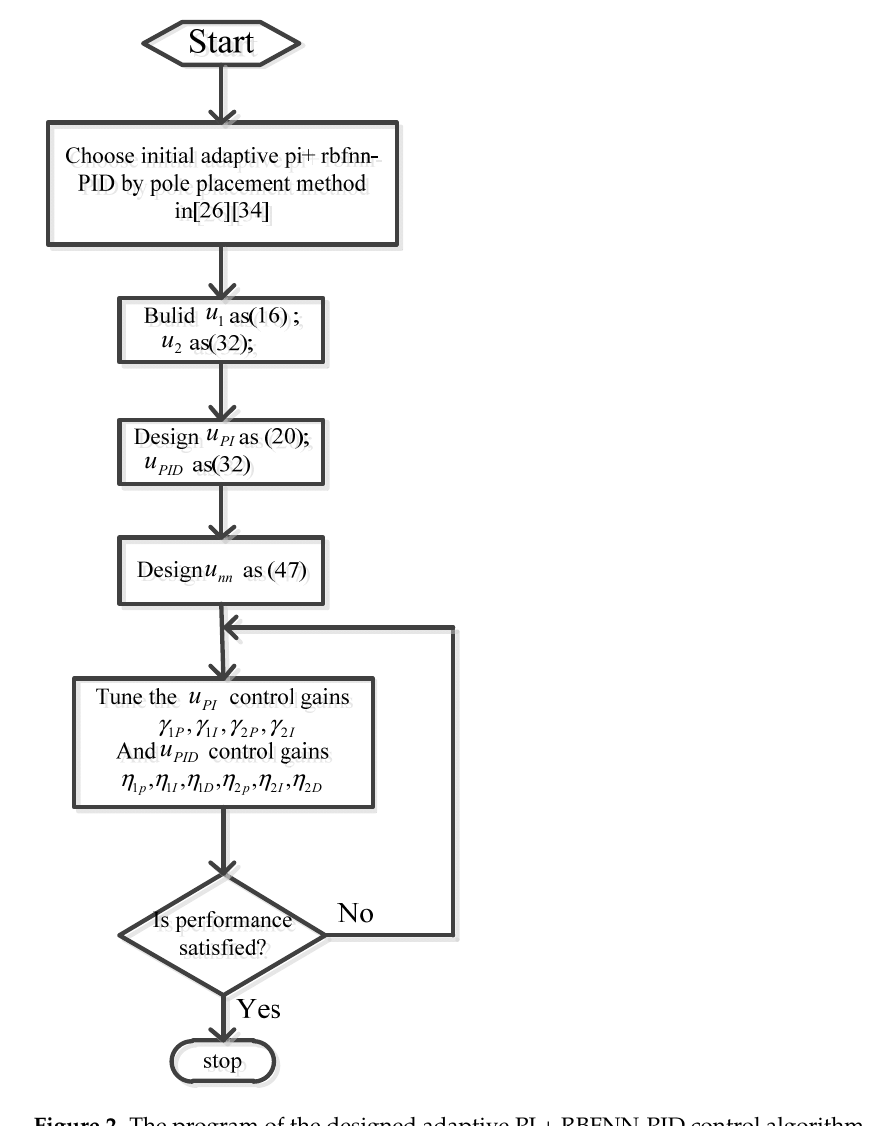
Figure 2. The program of the designed adaptive PI + RBFNN-PID control algorithm.